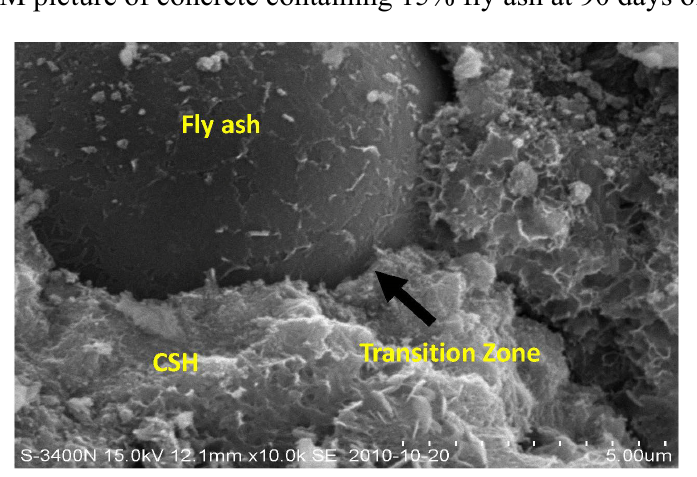
Figure 7. SEM picture of concrete containing 15% fly ash at 90 days of immersion.